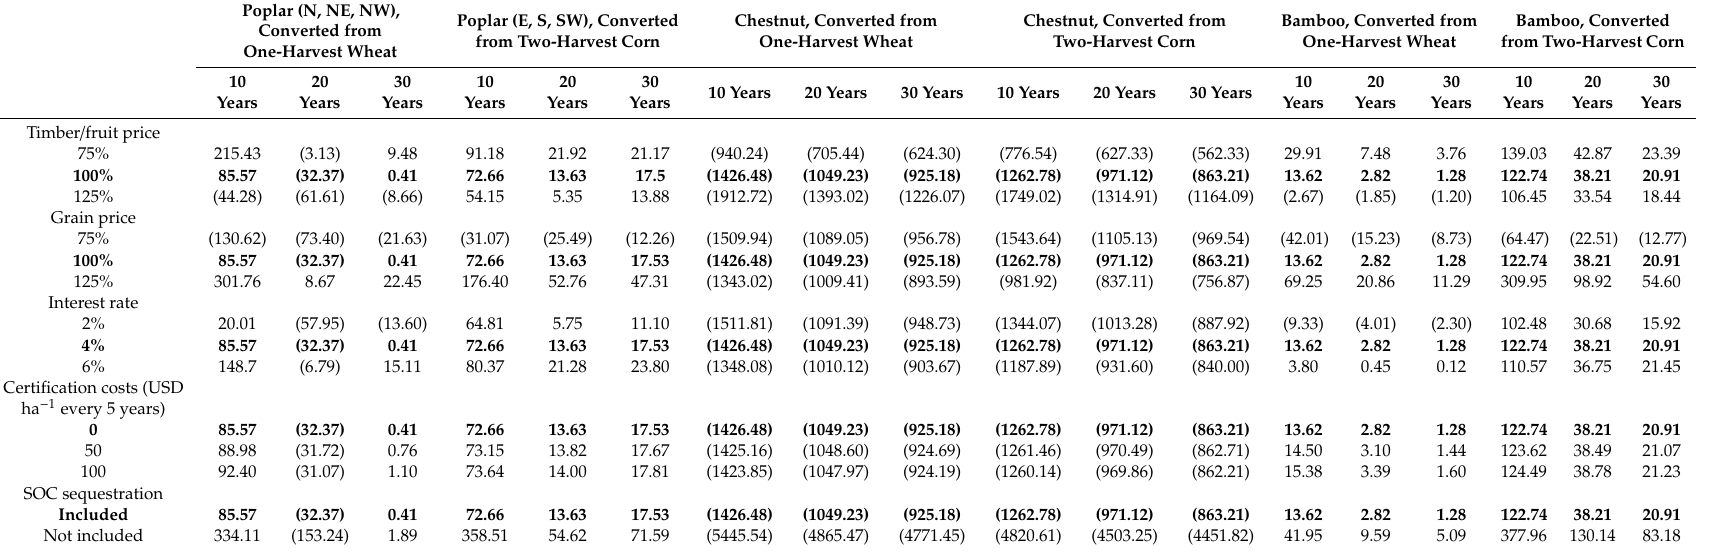
Table 7. Sensitivity analysis for the minimum price per tCER for di ff erent a ff orestation alternatives (USD Mg − 1 CO 2